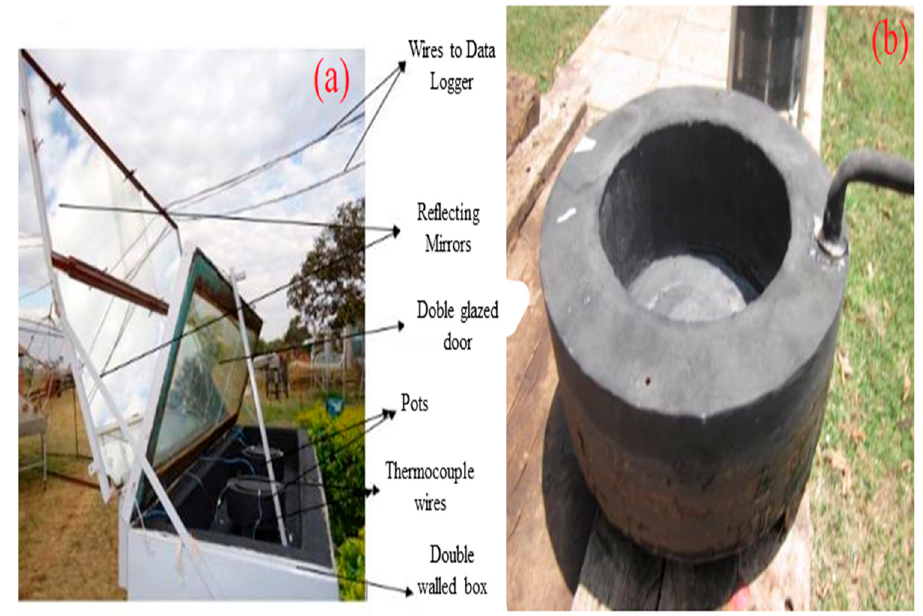
Figure 22. Solar cooker set with PCM storage unit: ( a ) Experimental setup; ( b ) PCM storage unit. Reprinted/adapted with permission from Ref. [66], 2019, Jomo Kenyatta University of Agriculture and Technology.